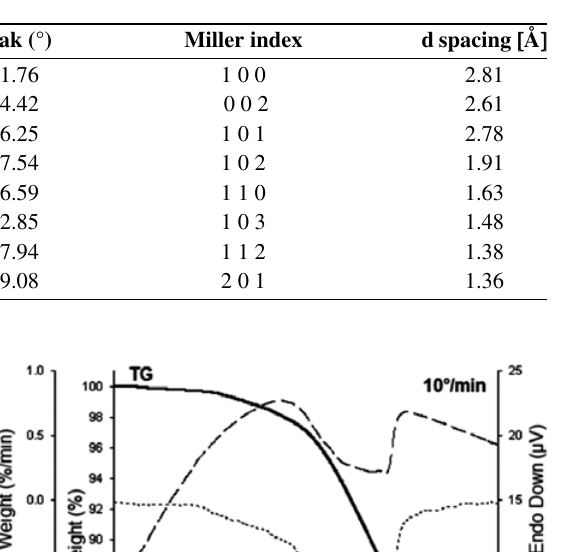
B O · 3.5H O, a. at 10 °C/min, b. at 15 °C/min, c. at 20 °C/min, d. Thermal kinetic curves of Zn 3 6 12 2 B O · 3.5H O by Kissinger 3 6 12 2 Ersan et al.: A Novel Synthesis of Zinc Borates from ...